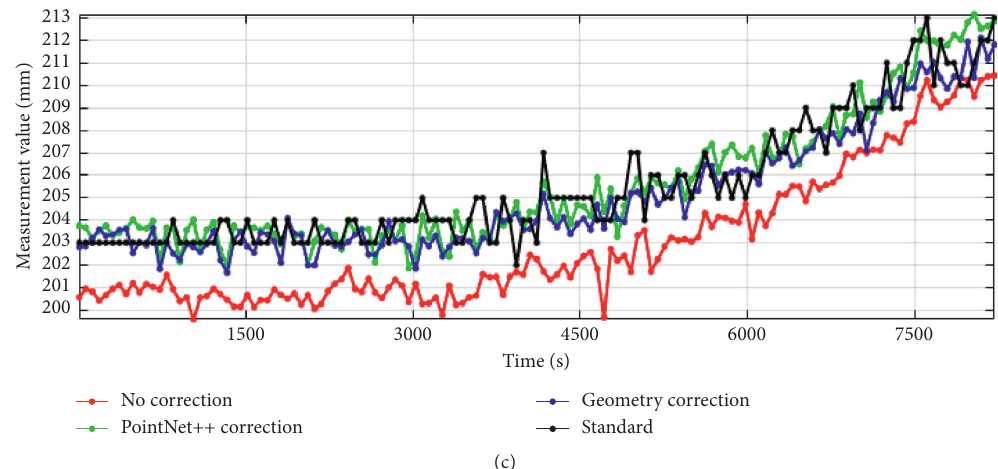
Figure 20: Real-time measurements: (a) real-time measurement of specimen 1; (b) real-time measurement of specimen 2; (c) real-time measurement of specimen 3.